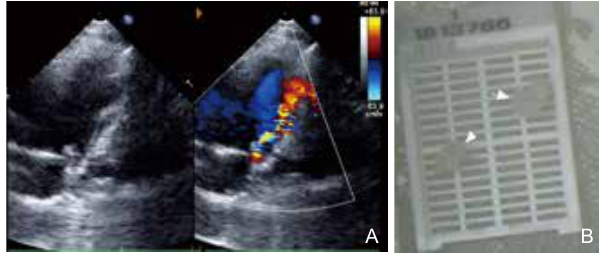
A Figure 3 A 23-year-old female with an intrapulmonary artery mass and PDA (Patient No. 15). In the 2D TTE image, the white arrow points to the mass attached to the pulmonary artery where the ductus arteriosus was connected, and a left-to-right shunt was confirmed by the color Doppler (A). The mass was complete resection (B). PDA, patent ductus arteriosus